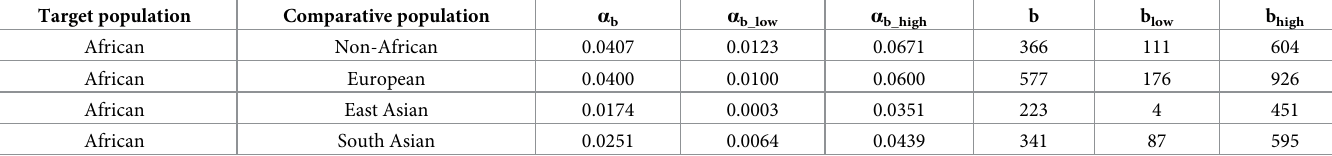
Table 1. The level of balancing selection in humans. Estimates of the proportion of shared nonsynonymous polymorphisms under balancing selection, α b , and the num- ber of polymorphisms, b , being directly maintained by balancing selection for population comparisons in which Z > 1. Code to extract and analyse the data can be found at